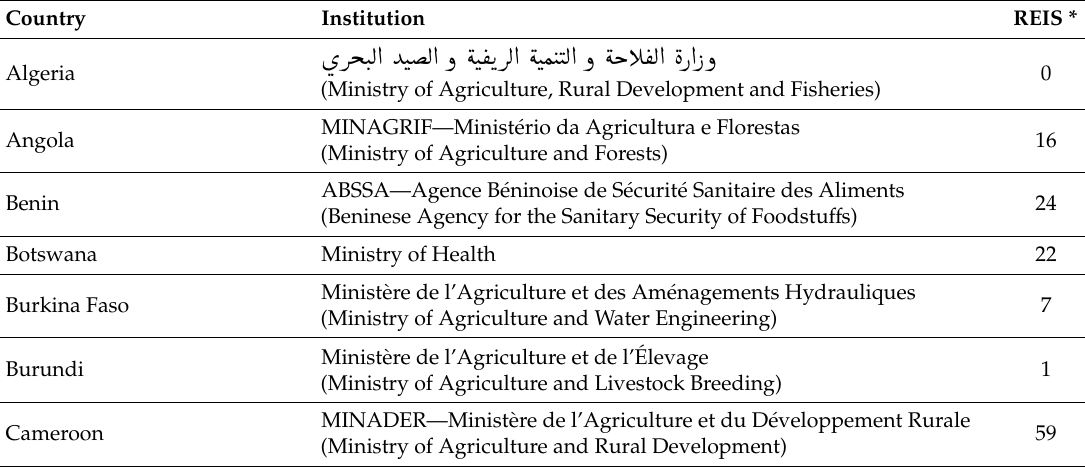
Table 3. List of African countries and authorities that provided information on the legal status of edible insects including the amount of edible species per countries according to Jongema [11]; besides these country-specific data, 4 species were recorded for Northern, 91 for central, 2 for Western, 9 for Eastern, and 20 for Southern